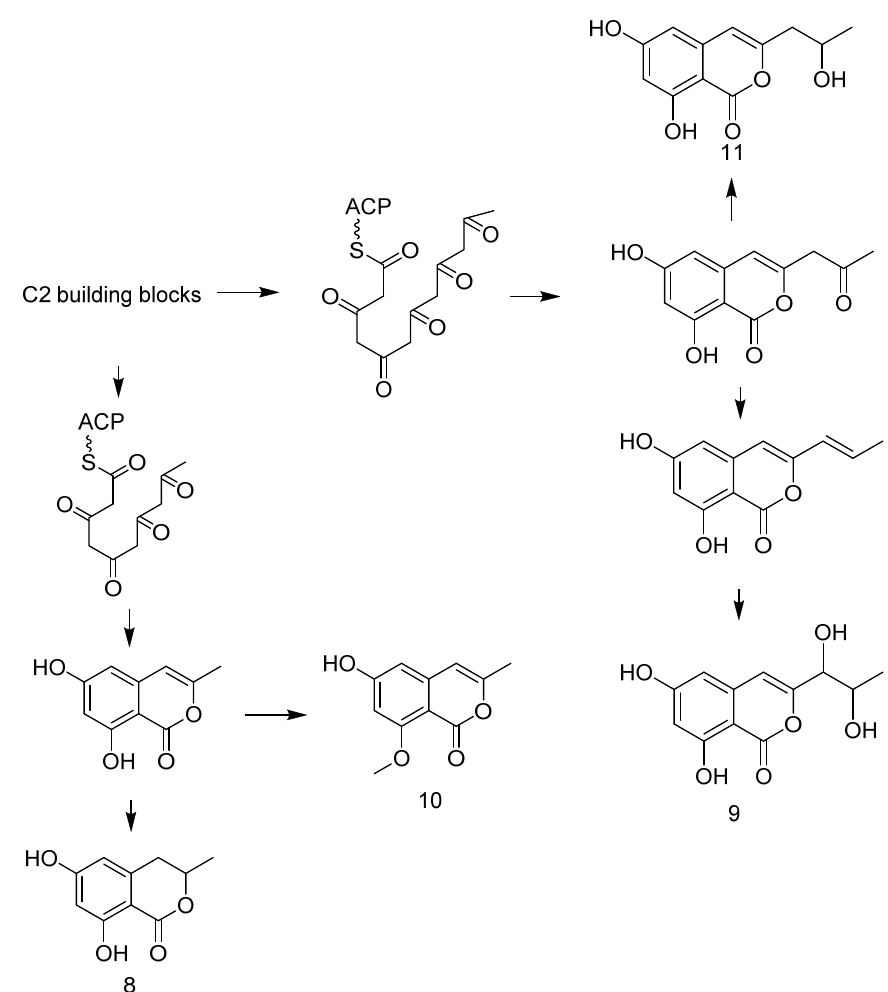
Table 4. Acetylcholinesterase inhibitory activities of the secondary metabolites of Phaeosphaeria sp. LF5, expressed as IC 50